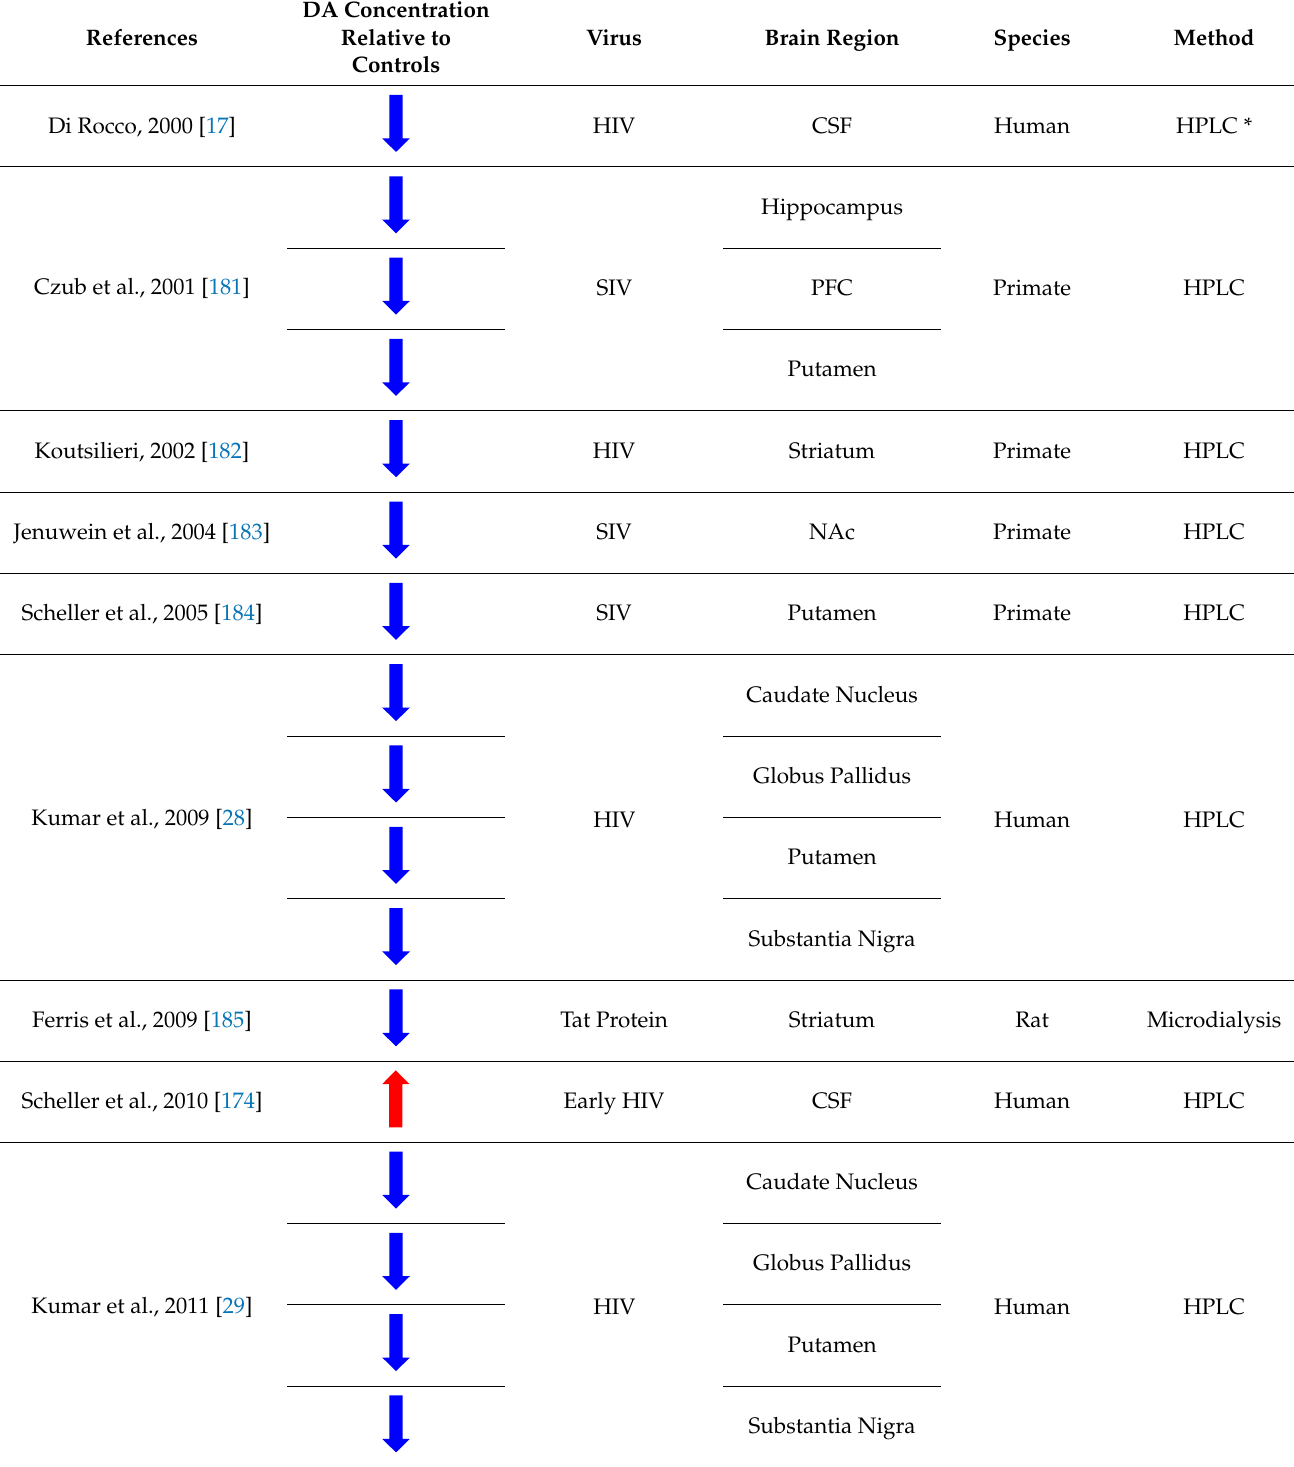
Table 2. Influence of HIV-1 viral protein exposure on dopamine (DA) concentration relative to con- trols. Asterisks (*) indicate manuscripts that measured DA metabolites (e.g., homovanillic acid). Symbols: DA concentration is decreased ( ) or increased ( ) relative to controls. The equal sign ( ) indicates no statistically significant differences in DA concentration between HIV and con- trols.